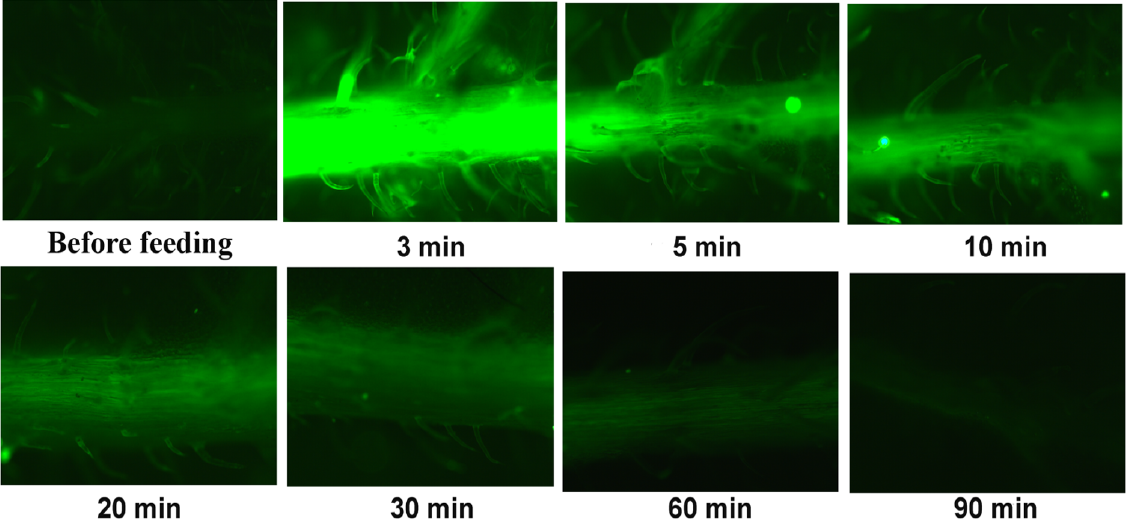
Figure 6. Reactive oxygen species (ROS) localization by staining of potato leaflet with 2 ′ , 7 ′ -dichlorofluorescein diacetate (DCF-DA) before and after 3-, 5-,10-, 20-, 30-, 60-, and 90-min of feeding by Halyomorpha halys . Increased ROS generation visible by light green colour.